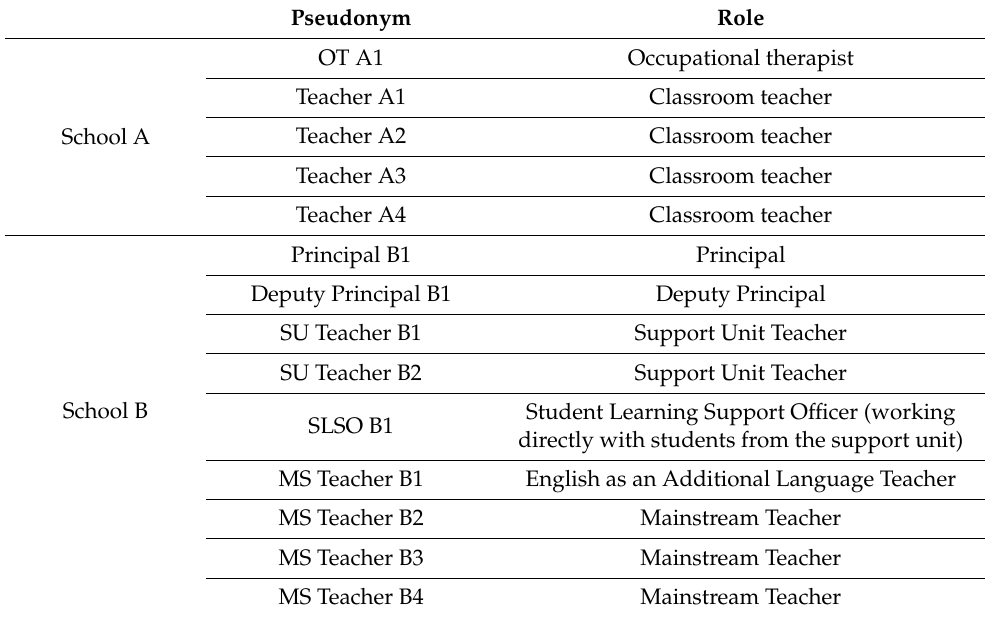
Table 2. Interview participants, pseudonyms, and